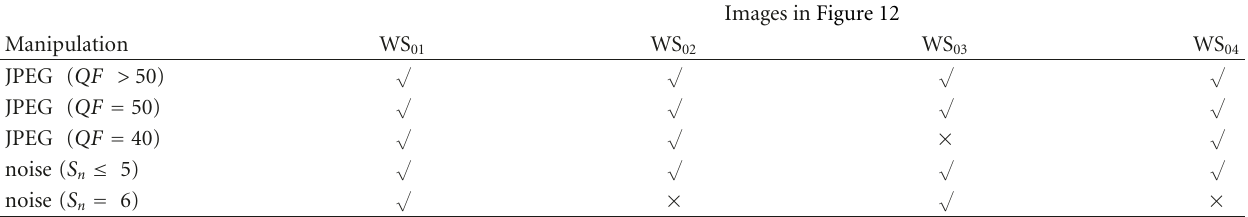
Table 5: Authentication results when JPEG compressions are applied to the watermarked seal images. those used in Table 4.